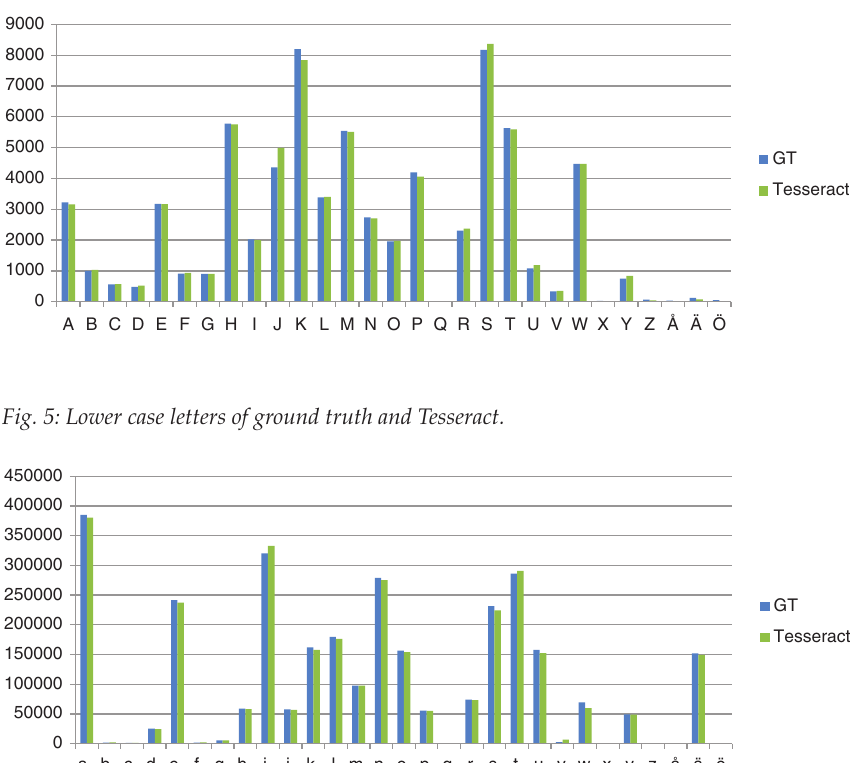
Fig. 4: Upper case letters of ground truth and Tesseract.